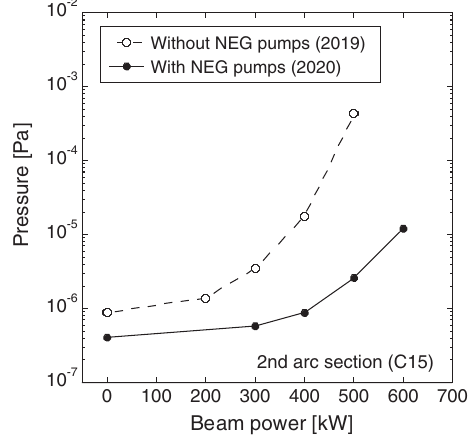
FIG. 29. Beam power dependence of the pressure measured by the CCG in C15 of the second arc section without and with NEG pumps during the beam operation. Each data is obtained in 2019 and 2020, respectively. The maximum pressure in each beam power operation is plotted. The values are obtained from Figs. 17(b) and 28 for the case without and with NEG pumps, respectively.